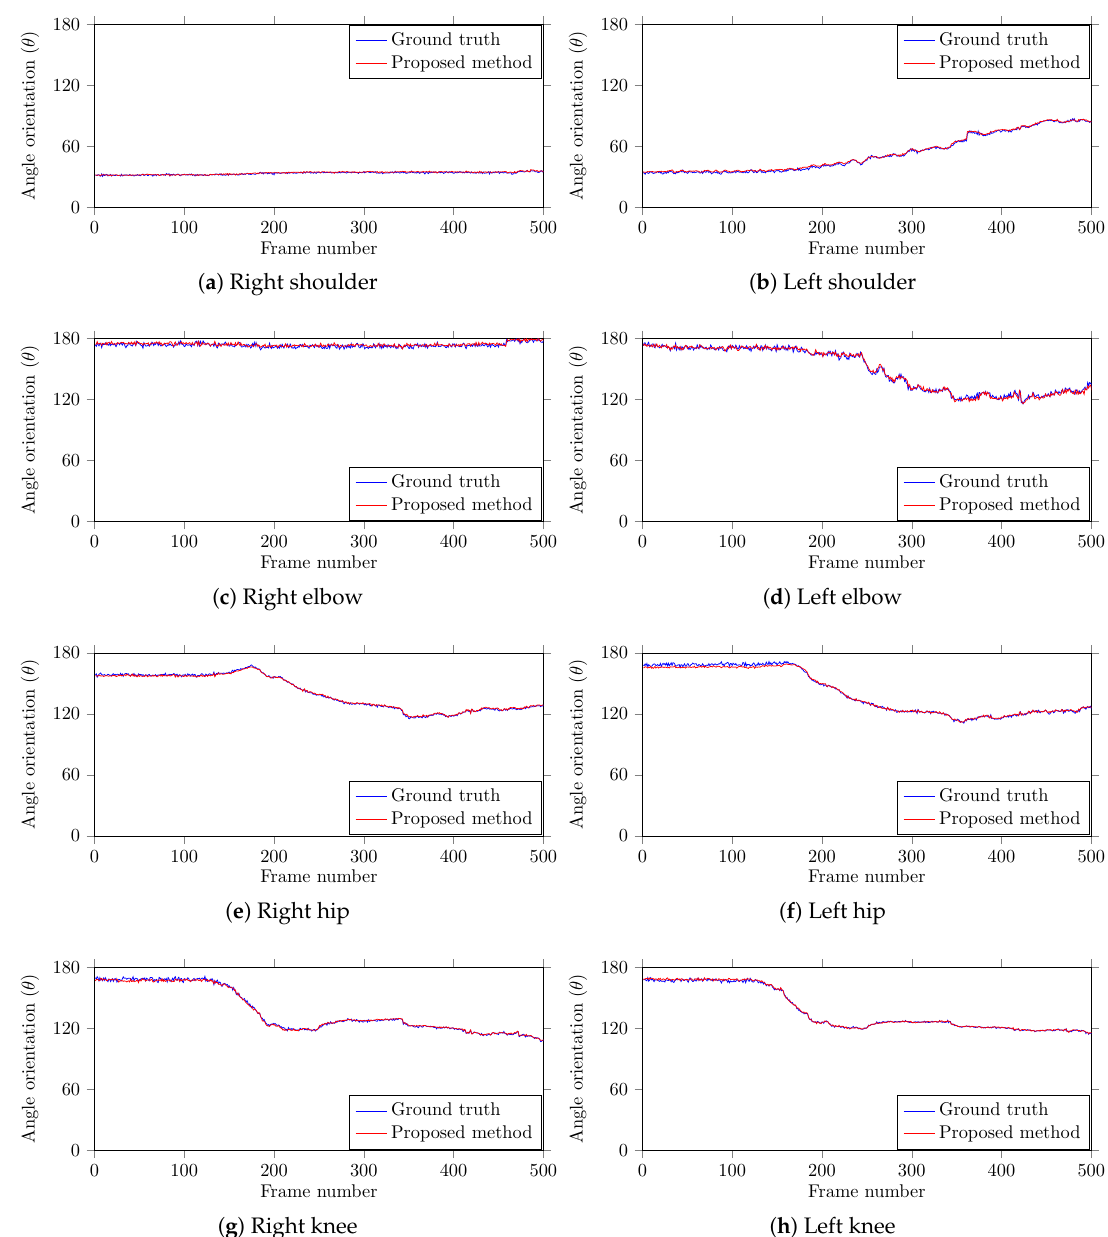
Figure 5. Predicted and ground truth angle orientations of different joints in a video sequence with 500 frames from our test dataset. In each graph, the angle orientation ( θ ) is computed in the sagittal